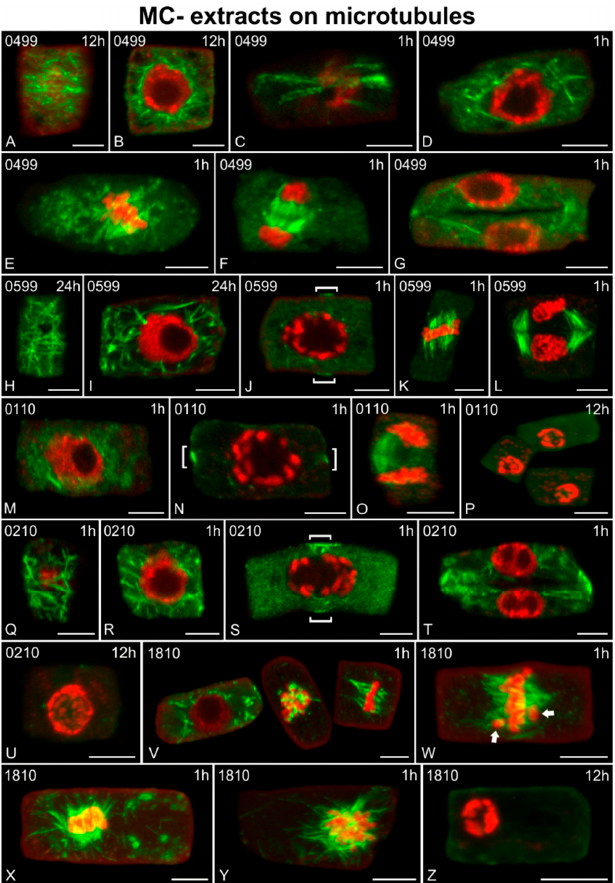
Figure 12. Single cortical ( A , C , H , Q ), single central ( B , D , F , G , I , J , M – O , S , T , V ), and maximum intensity projections of serial ( E , K , L , P , U , W – Z ) CLSM sections of Oryza sativa root meristematic cells, after α -tubulin immunostaining (green) and DNA staining with DAPI (pseudo-coloration in red). The cells depicted are from roots treated for various time periods (indicated on each image) with MC − extracts from non-MC-producing cyanobacterial strains: Synechococcus sp. TAU-MAC 0499 ( A – G ), Chlorogloeopsis fritschii TAU-MAC 0599 ( H – L ), Jaaginema sp. TAU-MAC 0110 ( M – P ), Jaaginema sp. TAU-MAC 0210 ( Q – U ), and Microcystis sp. TAU-MAC 1810 ( V – Z ). Images ( A – D ) and ( Q , R ) depict the same cells at cortical and central sections. 0499 : Affected interphase cells ( A – D ) exhibited diminished cortical ( A , C ) and prevalent perinuclear ( B , D ) microtubules. In affected mitotic cells, short dispersed spindle microtubules ( E ), almost normal early phragmoplasts ( F ), as well as disorganized advanced phragmoplasts ( G , though some long microtubules persist) with thick floating cell plates, were observed. 0599 : Affected cells exhibited disoriented cortical ( H ) and many perinuclear and endoplasmic microtubules ( I ) at interphase, faint PPB and scarce perinuclear microtubules at preprophase ( J , brackets indicate PPB), short spindle microtubules at metaphase ( K ) and long phragmoplast microtubules at cytokinesis ( L ). 0110 : After 1 h of treatment, endoplasmic tubulin aggregations at interphase ( M ), absence of perinuclear microtubules at preprophase ( N , brackets indicate PPB) and unilateral, long phragmoplast microtubules at cytokinesis ( O ) were observed in affected cells. After 12 h, disappearance of microtubules and abnormally condensed chromatin were common effects ( P ). 0210 : After 1 h of treatment, disoriented cortical microtubules ( Q ), along with many endoplasmic microtubules ( R ) could be observed in affected interphase cells. Other defects observed were the absence of perinuclear microtubules at preprophase ( S , brackets indicate PPB) and altered phragmoplasts with abnormally thick cell plates ( T ). After 12 h, no microtubules could be detected, and chromatin state was also abnormal ( U ). 1810 : After 1 h of treatment, affected cells exhibited numerous endoplasmic microtubules (left cell in V ), abnormally short microtubules attached to chromosomes (middle cell in V ) and malformed mitotic spindles (right cell in V ). Misaligned chromosomes, outside the equator plate (arrows in W ) could also be observed, as well as masses of chromosomes attached to aberrant spindle-like microtubules ( X , Y ). After 12 h, no tubulin polymers could be detected, while chromatin was abnormally condensed ( Z ). Scale bars: 5 µ